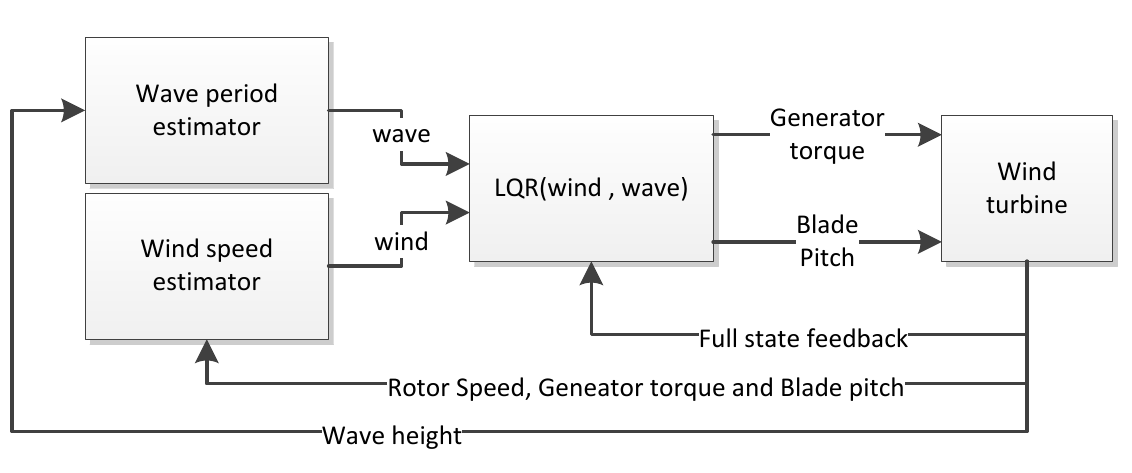
Figure 7. Overview of control